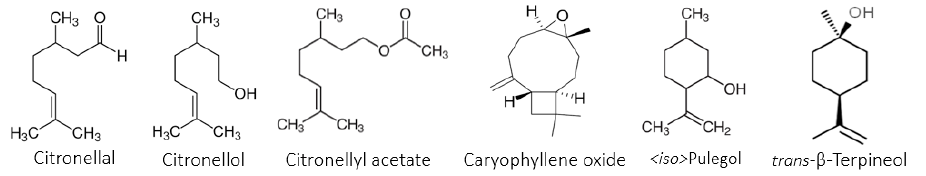
Figure 3. Major compounds of essential oils of E. citriodora .